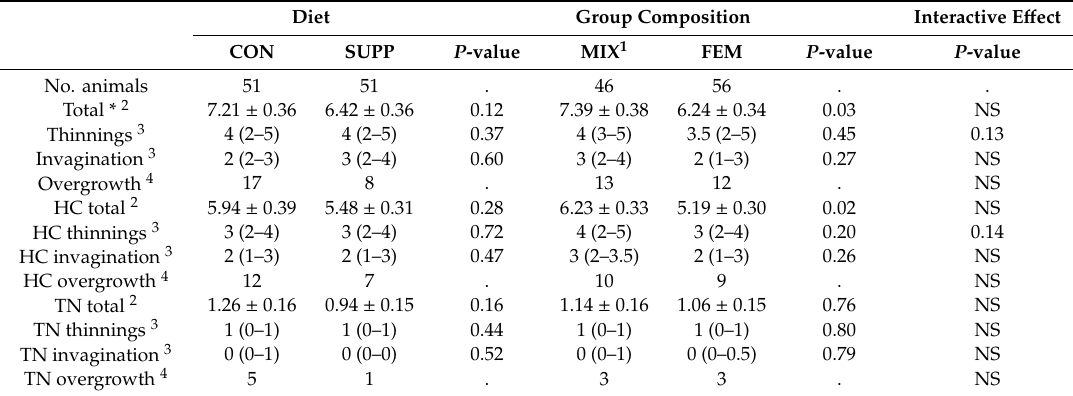
Table 5. The number of instances of thinning, invagination, and overgrowth of the cartilage in the joints of gilts reared in either mixed sex (MIX) or female-only (FEM) groups and on a standard finisher diet (CON) or on a CON diet supplemented with minerals (SUPP). Diet Group Composition Interactive E ff